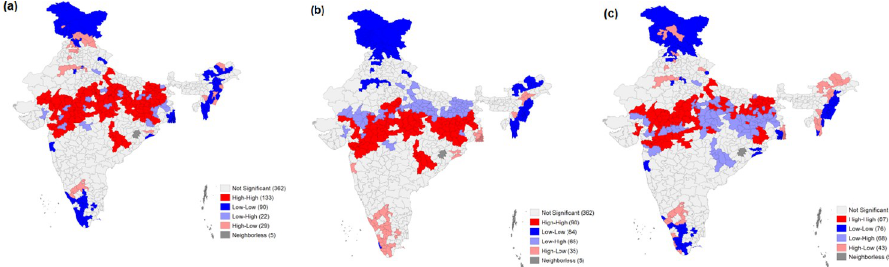
Fig 6. Bivariate LISA cluster maps showing the spatial clustering of wasting with a. Minimum meal frequency (MMF) b. Minimum dietary diversity (MDD) and c. Minimum acceptable diet (MAD) among children aged 6–23 months, India,